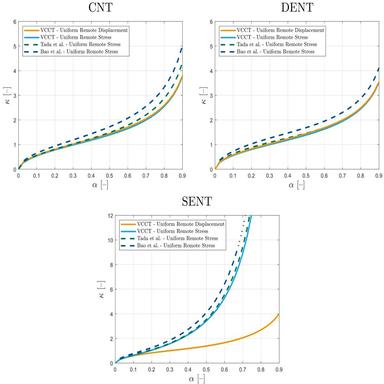
Analytical and numerical solutions for κ, considering specimens with shape parameter ξ = 3.